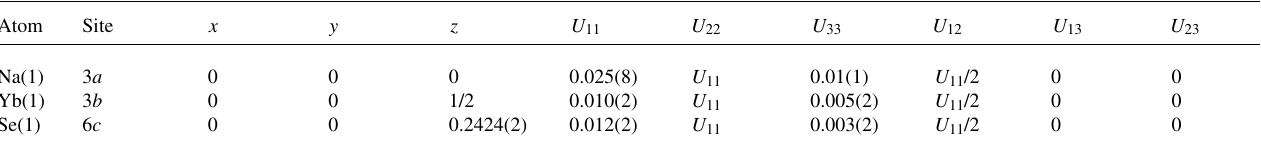
Table 2. Atomic coordinates and displacement parameters (in Å 2 ) .